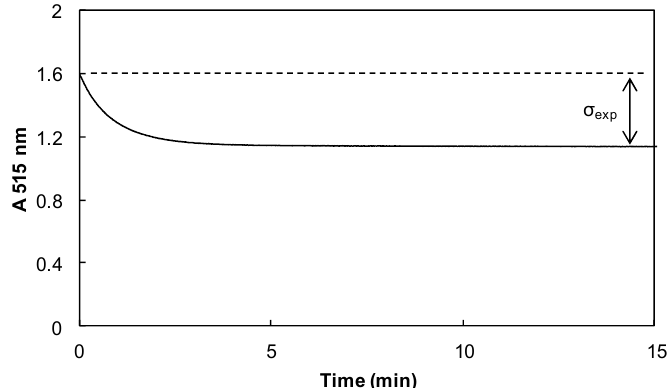
Figure 4. Evolution of the absorbance of DPPH • radical (1.5 × 10 − 4 mol·L − 1 ) at 515 nm in the presence